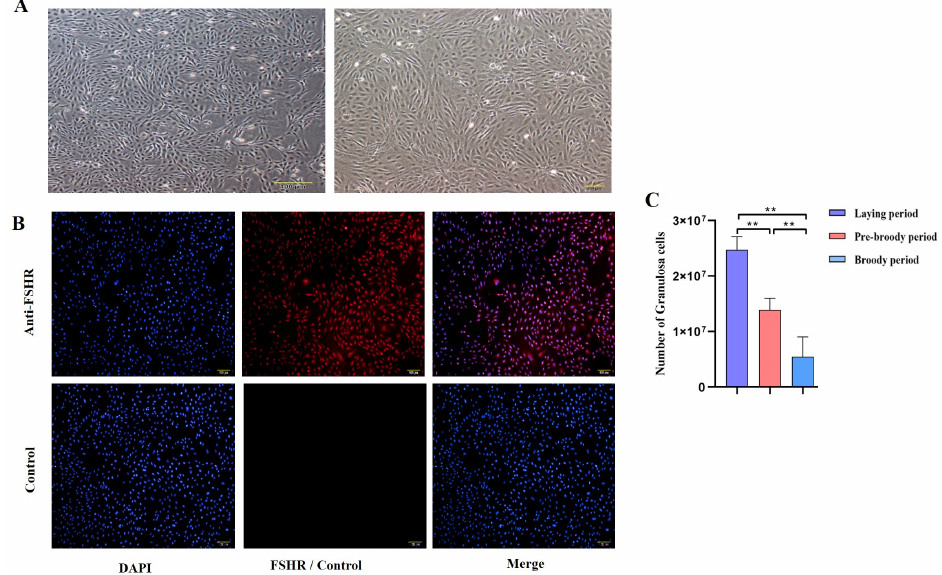
Figure 2. Change in the trend of the GC number. ( A ) Follicular GCs from geese were obtained by collagenase digestion and cultured, and images of goose GCs at 100× and 200× are shown. ( B ) The protein expression of follicle-stimulating hormone receptor (FSHR) in primary GCs was identified by indirect immunofluorescence staining. Left: DAPI staining of the cell nucleus; middle: fluorescence staining for FSHR; right: combined image of DAPI and FSHR staining. ( C ) The number of GCs was calculated by Trypan Blue counting ( n = 5). All the data are expressed as the means ± standard errors; ** indicates an extremely significant difference ( p <